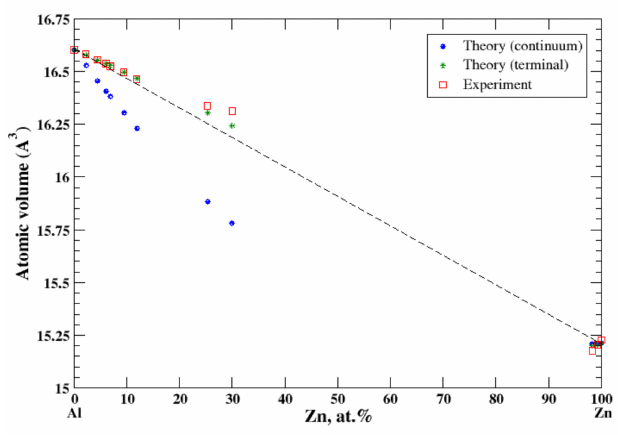
Figure 6. Atomic volume vs. concentration for Al-Zn alloy system. The experimental data are from Ref. [16] (p. 389 and p. 886).